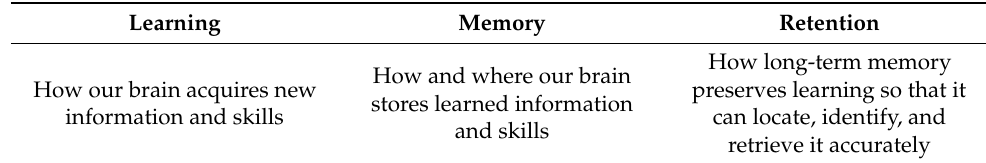
Table 2. On the differences between learning memory and retention.